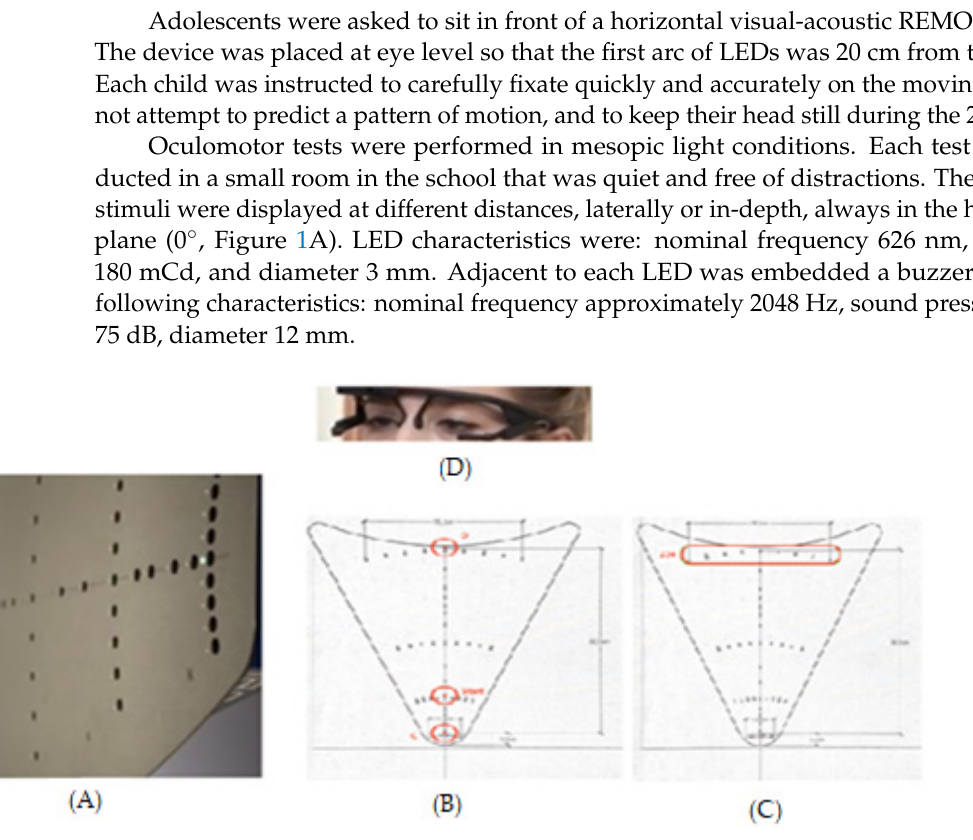
Figure 1. ( A ) The REMOBI device is a trapezoidal surface upon which are displayed LEDs coupled with a buzzer. The surface is placed at eye level. In ( B ) are shown in red the fixation point and the two possible target positions for the vergence test; in ( C ) is shown the central fixation target and the two possible lateral positions for the saccade test. In ( D ) the participant wears the Pupil Labs eye trackers.